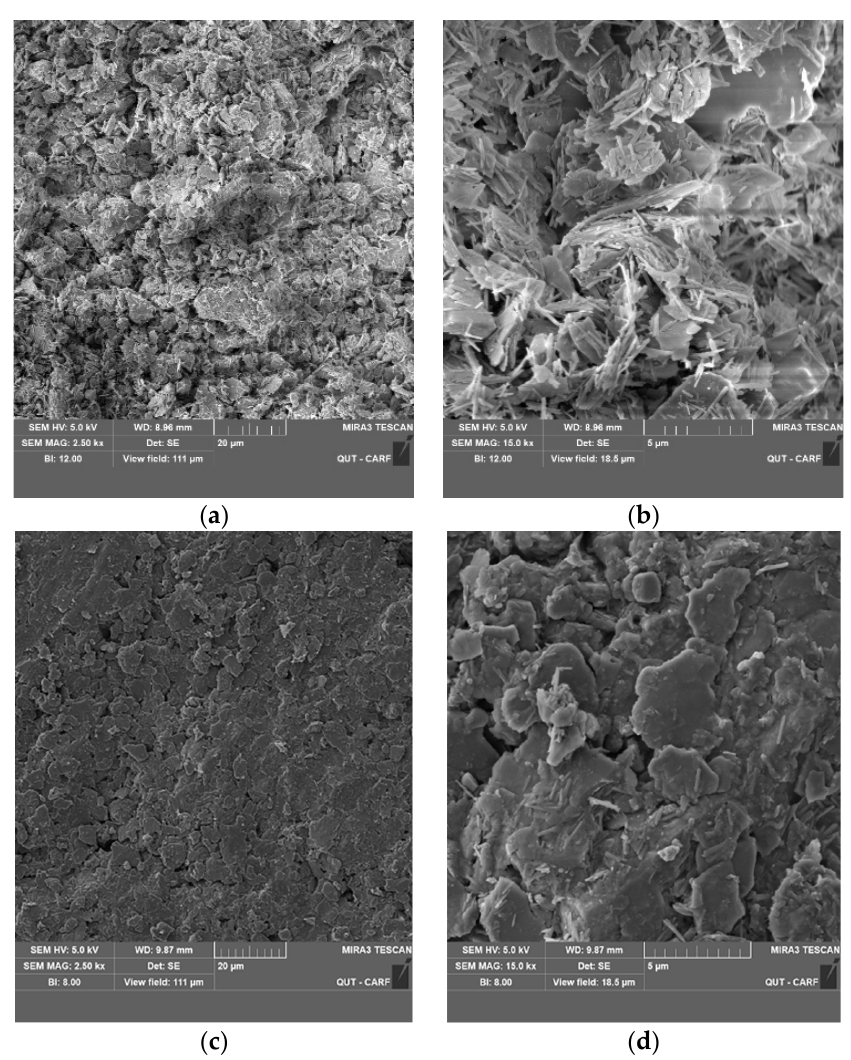
Figure 11. SEM images of the ( a ) pure soil with 2500× magnification; ( b ) untreated soil with 15,000× magnification; ( c ) LIG-treated soil with 2500× magnification; ( d ) LIG treated soil with 15,000× magnification.